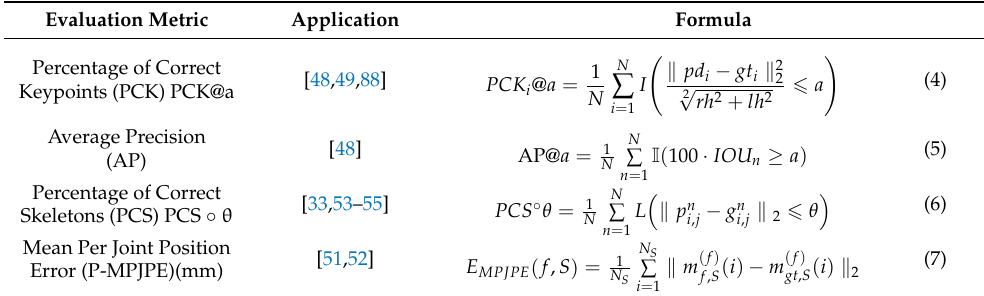
Table 1. Common Evaluation